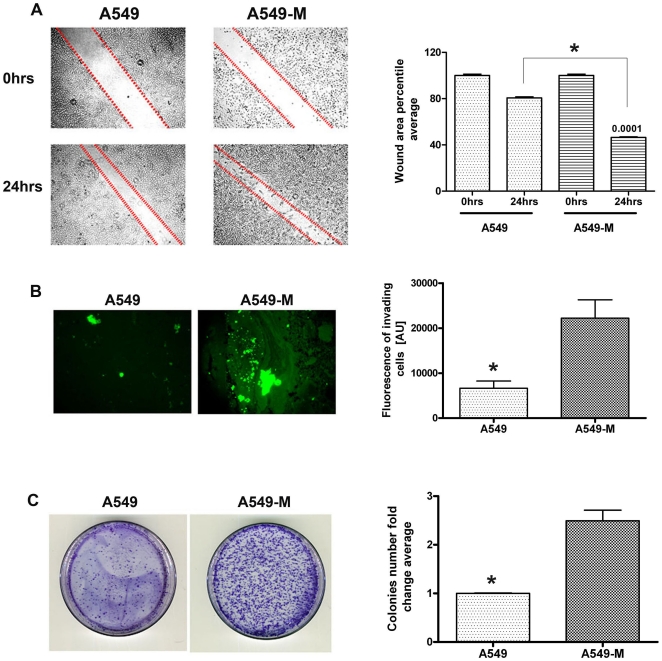
A549-M cells shows significant increase in migration, invasive, and tumorigenic characteristics compared to A549 parental cells:TGF-β1-induced EMT phenotypic cells (A549-M cells) were generated as discussed under “Materials and Methods” section. A: showed wound healing assay results with its quantitative analysis. A549-M cells showed much higher motility compared to A549 parental cells. B and C showing the results of matrigel-coated membrane, and colony formation assays, respectively with its quantitative analysis. Significant increase was observed in the invasion and clonogenicity of A549-M cells compared to parental A549 cells. (*  =  p<0.05).